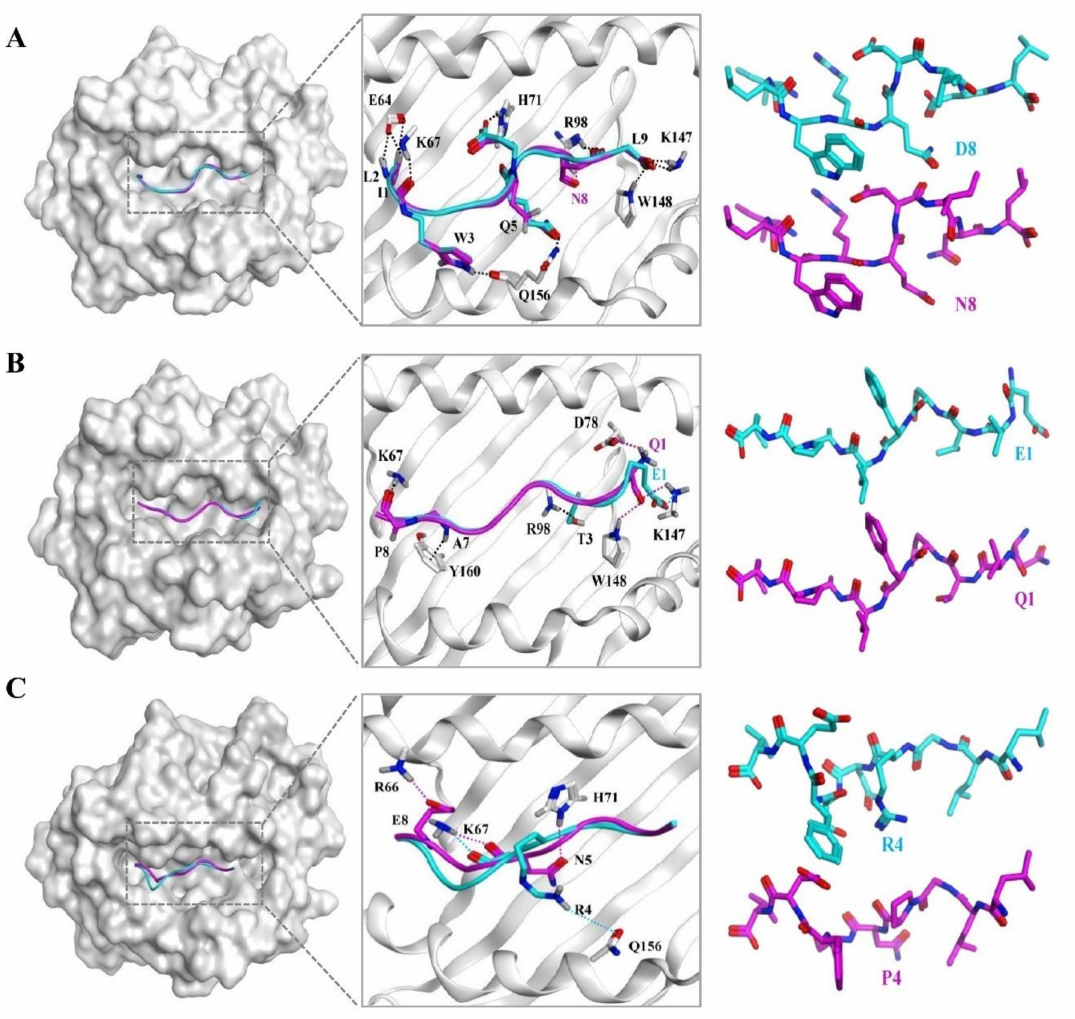
Figure 5. The possible structural models of the candidate peptide and HLA-A*0201 molecule. The structures of the WT peptides and MUT peptides were predicted by PEP-Fold. WT peptide (blue, ( A ): NFE2L2-WT; ( B ): PCLO-WT; ( C ): TP53-WT) or MUT peptide (magenta, ( A ): NFE2L2-D13N; ( B ): PCLO-E4090Q; ( C ): TP53-R267P) were docked with HLA-A*0201 molecule (gray) (PDB ID: 5YXN) by MOE (Molecular Operating Environment software). The binding sites of the peptides to HLA-A*0201 molecules are